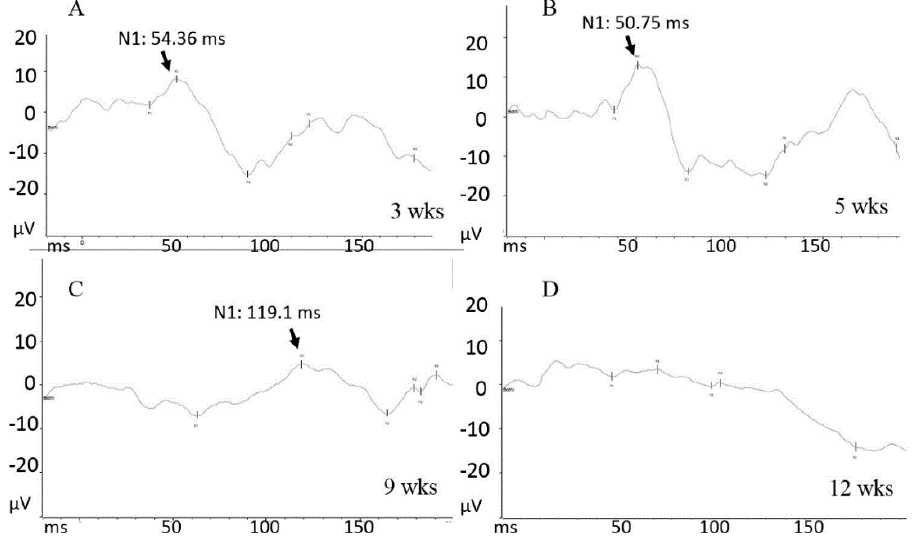
Figure 2. The records of visually evoked potential (VEP) at 3 ( A ), 5 ( B ), 9 ( C ), and 12 ( D ) weeks (wks) of RCS rats. X axis, ms: mini-second. Y axis, µ V, micro-voltage. The N1 latency, representing the time of photo-transduction rate from eye to visual cortex, is indicated by